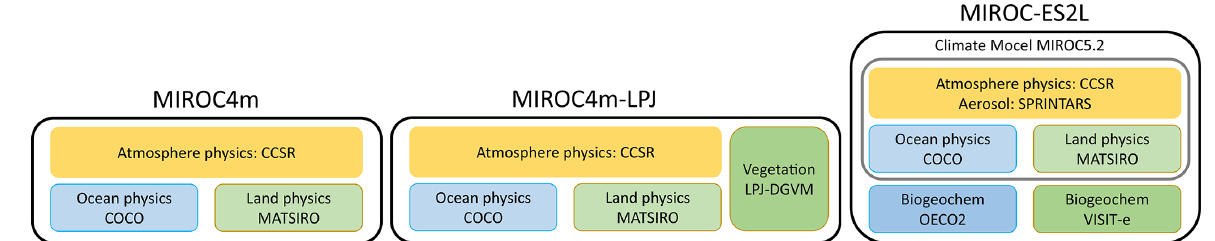
Figure 2. Schematic of